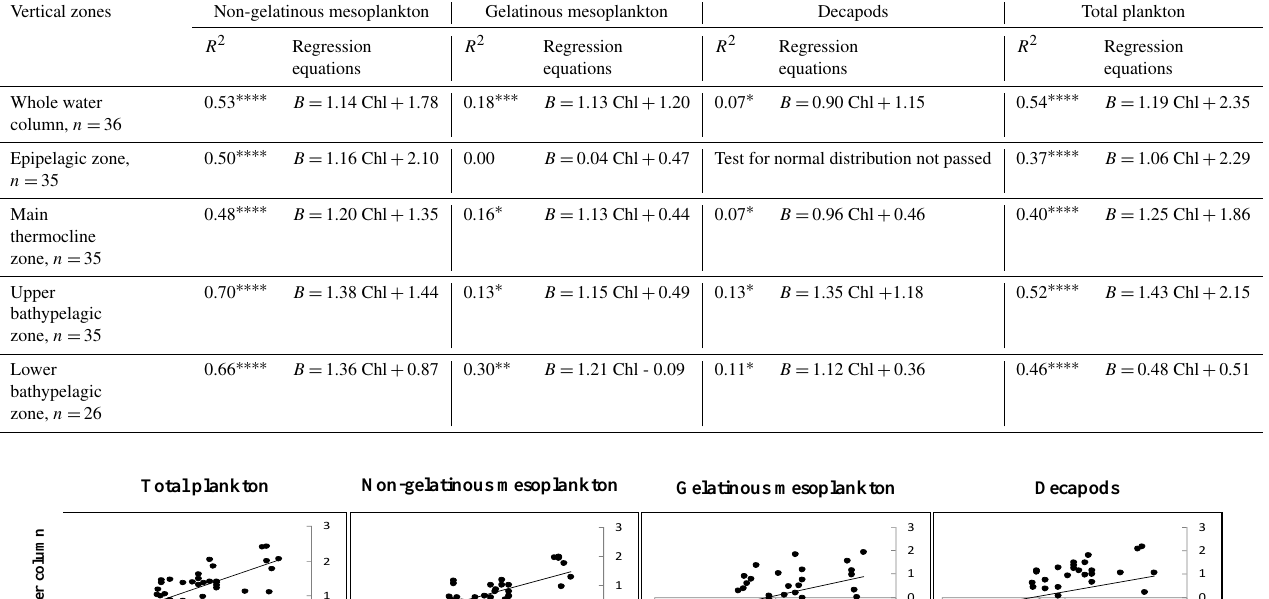
Vertical zones Non-gelatinous mesoplankton Gelatinous mesoplankton Decapods Total plankton equations equations equations equations